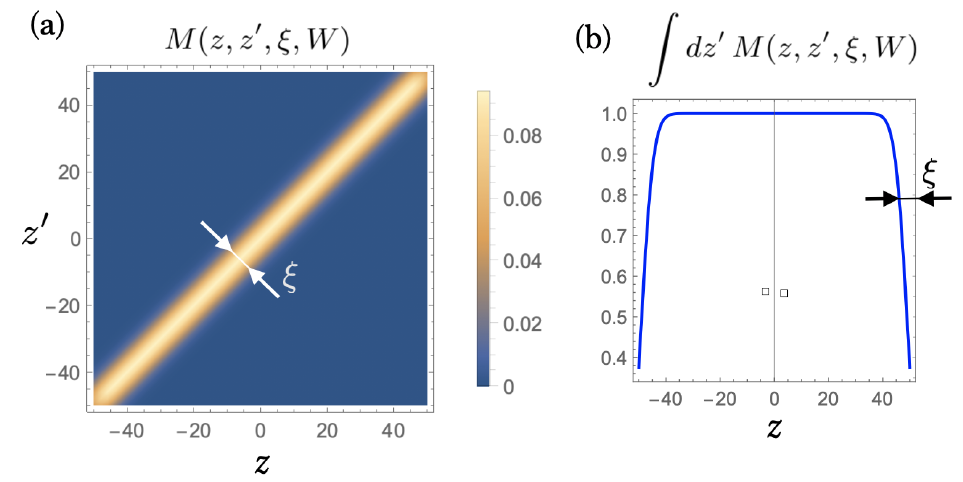
(cid:82) dz (cid:48) M ( z , z (cid:48) , ξ , W ) (b) at ξ = 3